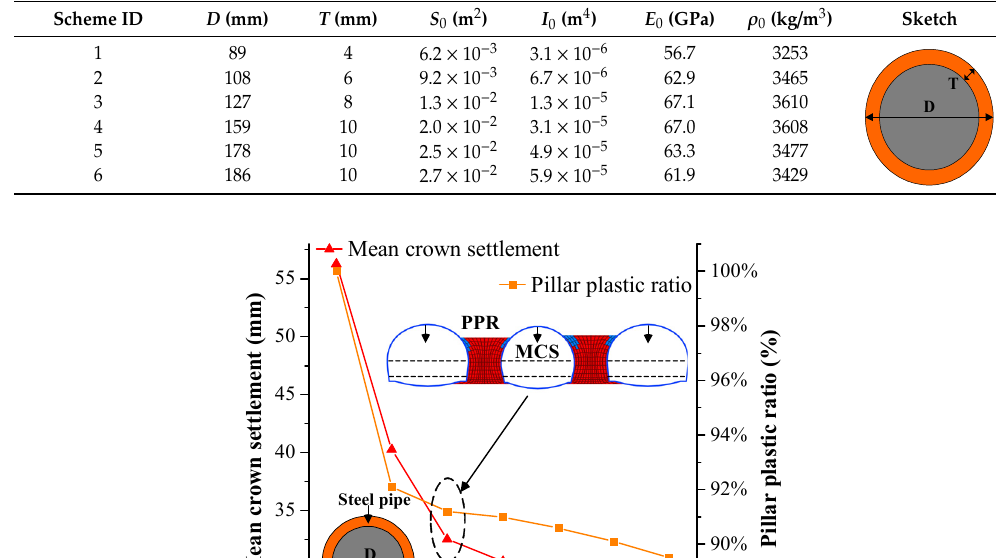
Table 3. Cross-section parameters of the pipe roof.